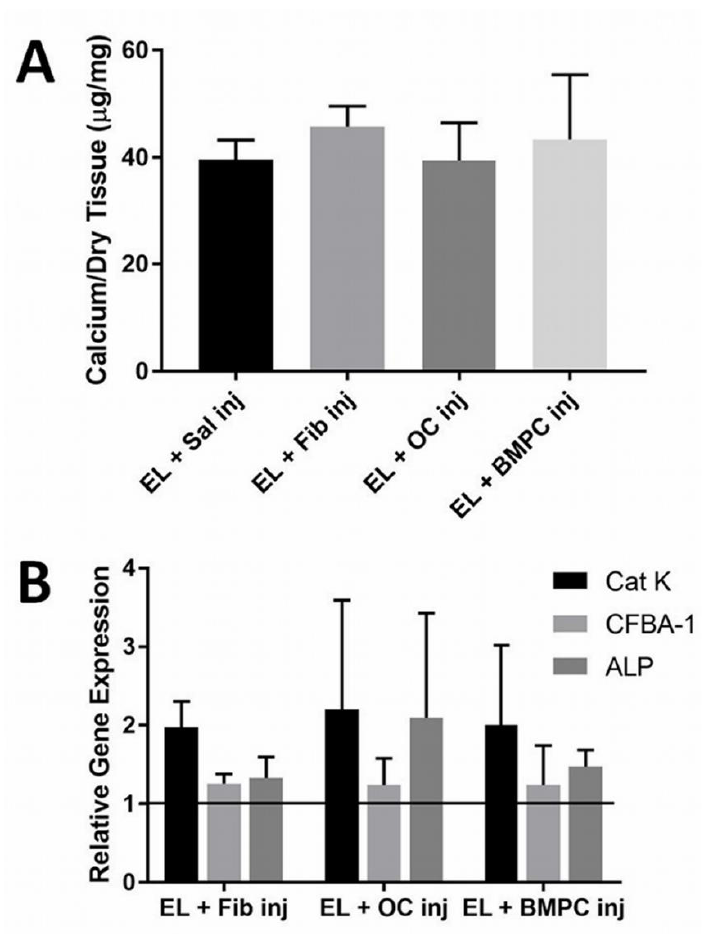
Figure 1. ( A ) The graph depicts the amount of calcium per dry tissue in µ g/mg, with elastin and OC injection showing the lowest amount of calcium, though no values were found to be significant. Cells injected at the site of elastin calcification were not effective in reducing calcification ( n = 4). ( B ) The second image depicts gene expression of each treatment, looking specifically at Cat-K, CFBA-A, and ALP. Gene analysis of the implants shows that cell injections did not reduce bone-specific genes, with all being found at expressions higher than a value of 1 ( n = 4). Data were analyzed with ANOVA and Student’s t -test, with p < 0.05.